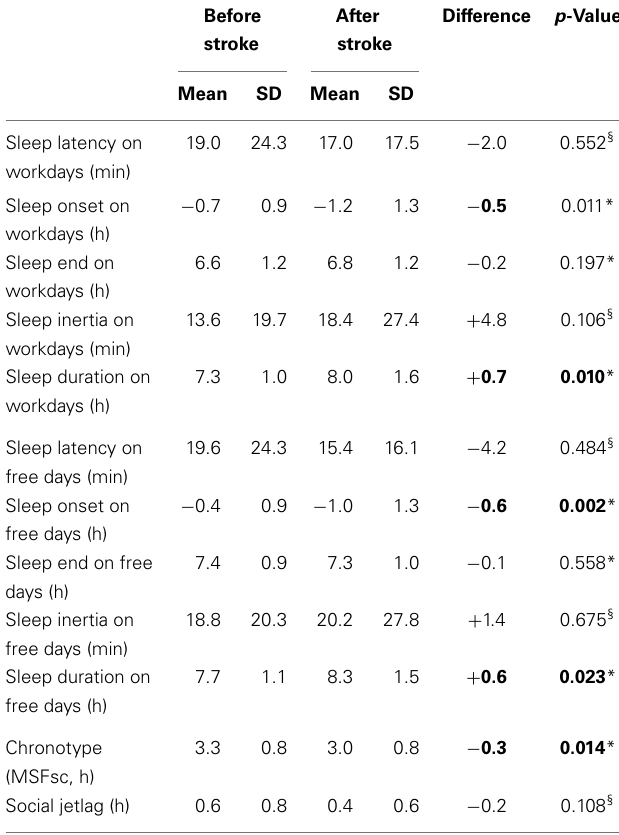
Bold numbers indicate statistically significant differences with *paired t-test and § Wilcoxon signed ranks